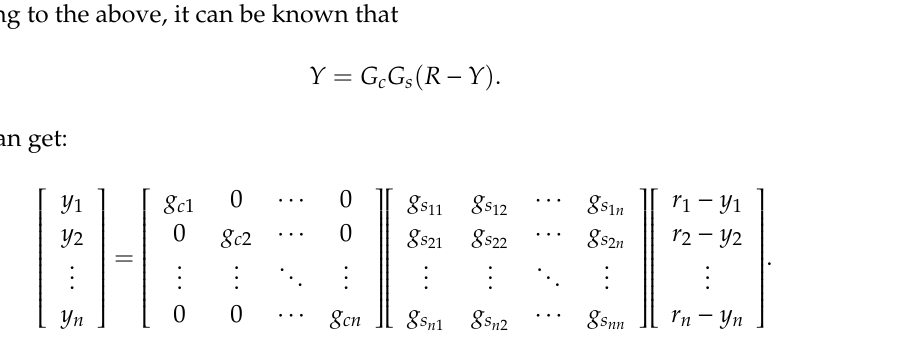
Figure 3. Diagram of the multivariable square closed-loop control system.